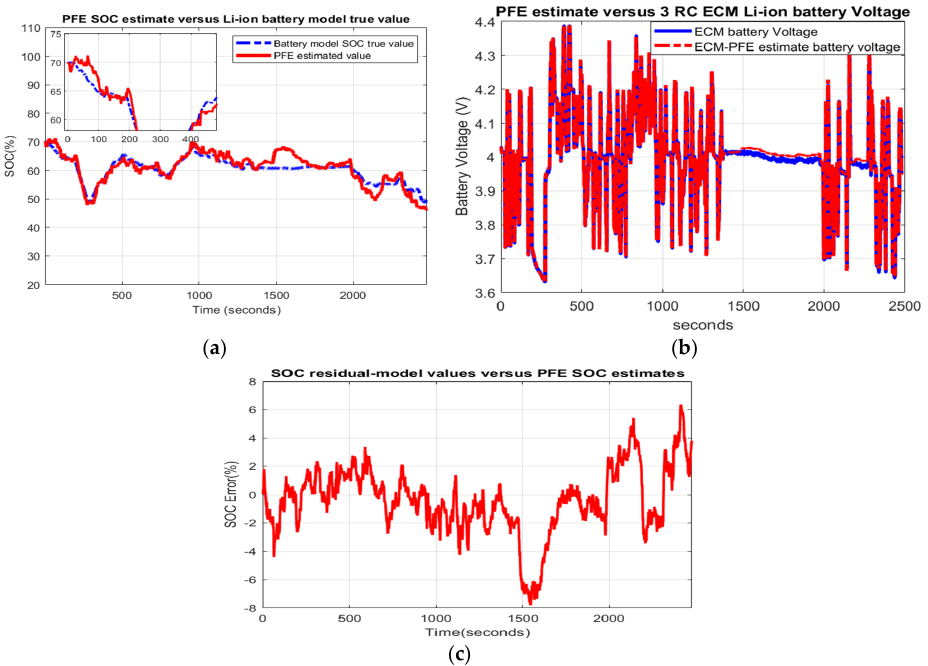
Figure A24. The MATLAB simulation results for Simulink Simscape Li-ion battery. ( a ) The PFE SOC value versus battery model SOC true value; ( b ) The PFE terminal output voltage versus battery 3RC ECM model terminal output voltage true value; ( c ) The SOC residual.